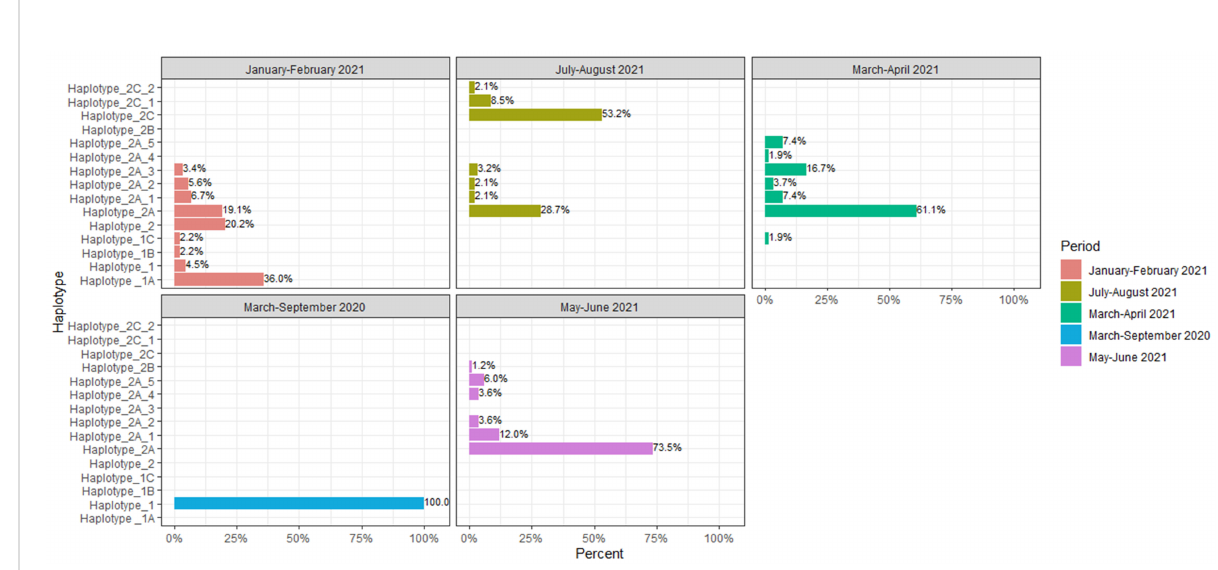
FIGURE 9 Schematic presentation of the distribution of haplotypes within different time periods of the